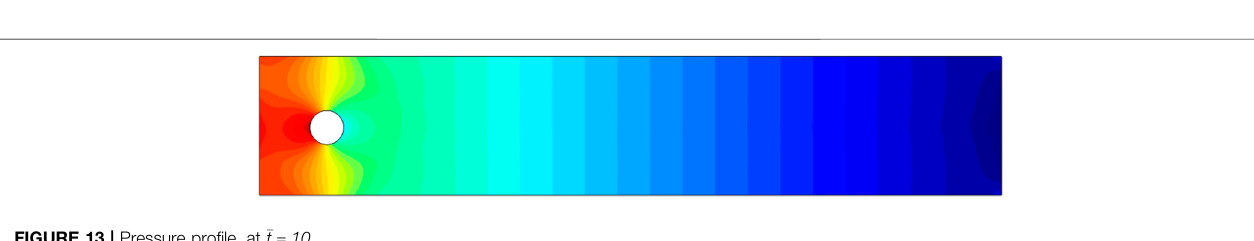
FIGURE 13 | Pressure pro fi le, at (cid:2) t (cid:1) 10 .